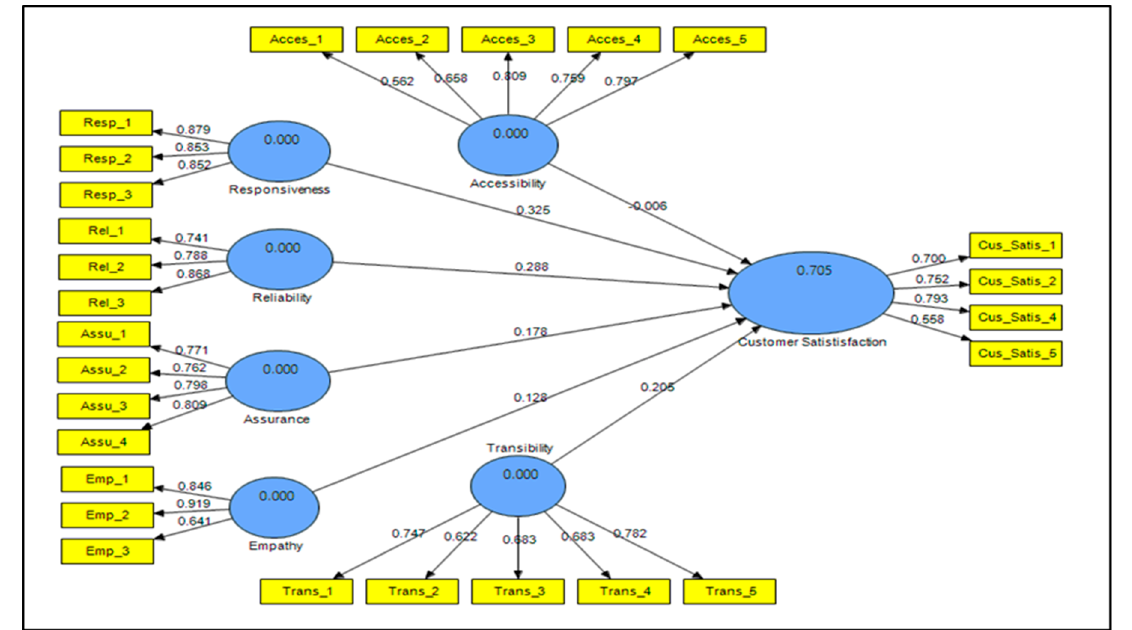
Figure 2. The measurement model (determinants) of service quality. Source: SmartPLS 2.0 outputs. The measurement model was tested using both the reliability and validity of the constructs. For indicator reliability (Table 2), the factor loading out of 37 items of the constructs, 26 items are qualified for the constructs based on a thumb value of 0.5 or above (Henseler et al. 2015). In addition, the composite reliability is above the threshold value of 0.70 (Shi et al. 2022), indicating the adequate reliability of the constructs. Cronbach’s Alpha represents within the range of 0.797 to 0.896, which is within the standard of 0.5 (Hair et al. 2014). Thus, reliability is achieved in this study. Table 2. The EFA of service quality and customer satisfaction.